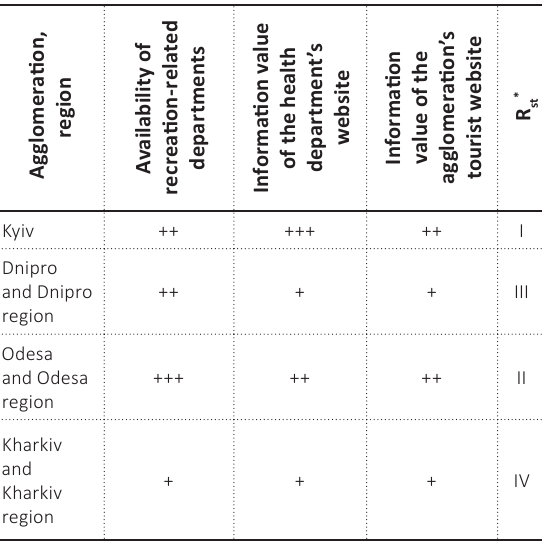
Table 1. The result of an analysis of the